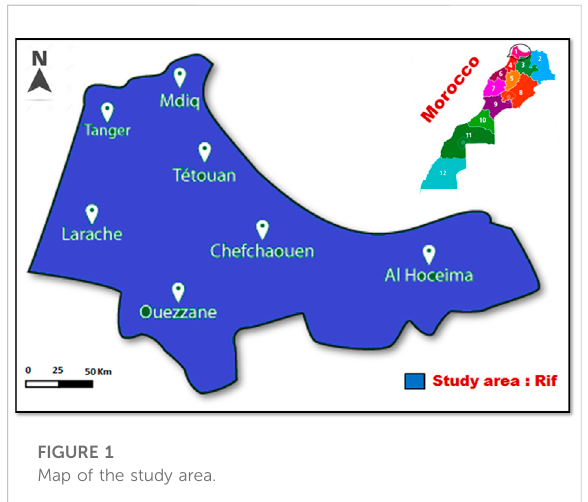
FIGURE 1 Map of the study